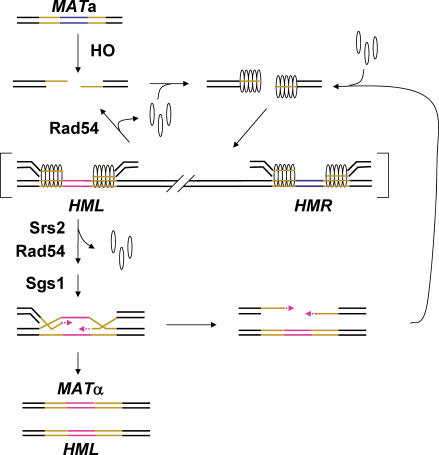
Model for DSB-Induced Pairing of MAT with Donor LociFollowing HO-induced double-strand cleavage of MAT, Rad51 (ellipses) binds to the resected single-strand ends of the DSB and promotes their association with both HML and HMR via homology present at all three loci. Blue- and pink-colored regions at the mating type loci represent allele-specific DNA sequences, which are bracketed by sequences in common among all three loci (shown in brown). Dissociation of these initial complexes, suggested to be paranemic joints in this illustration, is stimulated by Rad54-promoted removal of Rad51. Since these associations are seen only in rad54 cells, we assume that they are too short-lived to be evident in wild-type cells, and thus are indicated in brackets. We propose that Rad54 also stimulates conversion of the initial joint complex into an initial D-loop structure, also by promoting removal of Rad51, allowing subsequent extension of the heteroduplex between the invading strand and donor locus, and elongation of the invading strand. These subsequent steps are promoted or stabilized by Srs2 and Sgs1. Our results suggest that one or more of the later-stage intermediates in recombination, perhaps even after partial extension of the invading strand, are also reversible prior to completion of the gene conversion event. The dissociated, but incompletely healed, MAT locus then would recycle through Rad51 filament formation and reassociation with the donor locus, ultimately yielding a completely reconstituted MAT locus.